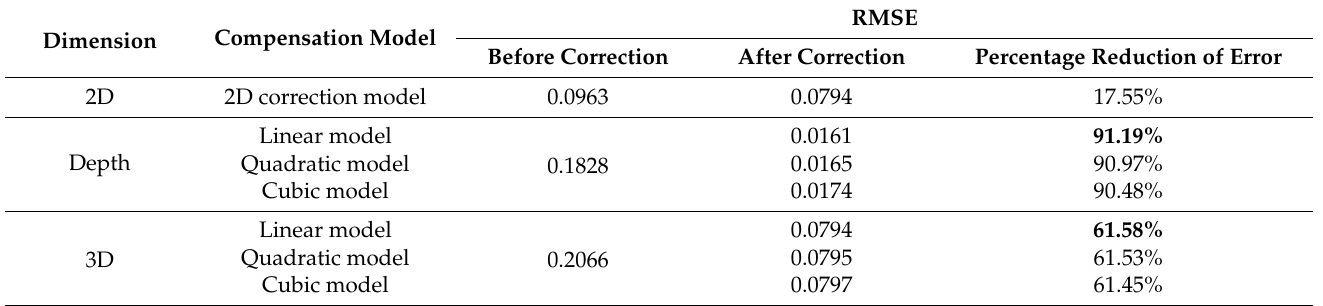
Table 1. Effects of three error compensation models. Bolded numbers indicate the best accuracy in the comparison.